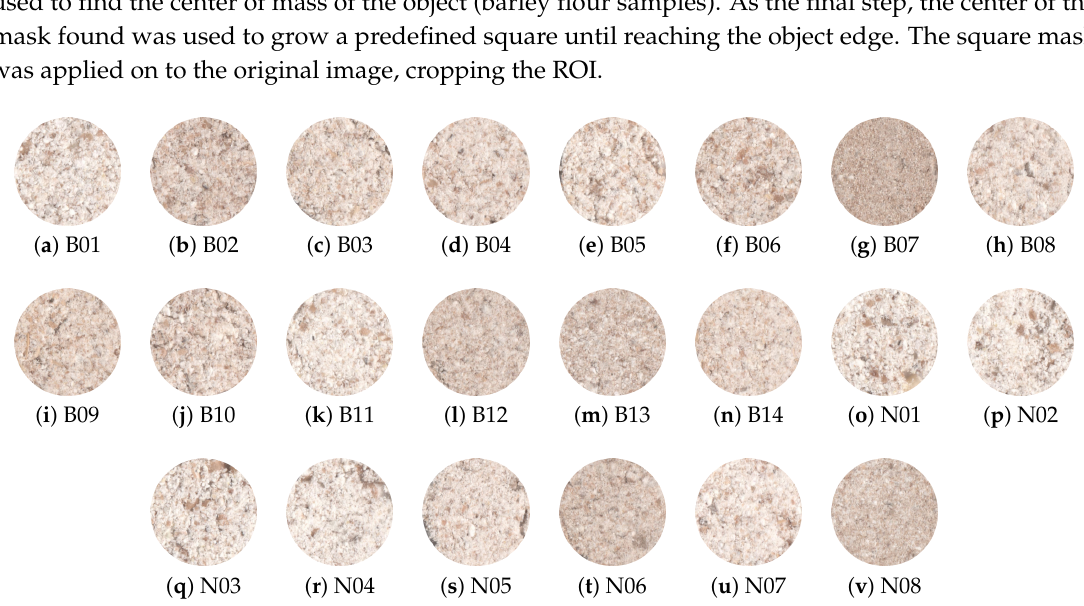
Figure 3. Samples of barley flour from malting ( a – n ) and naked ( o – v )